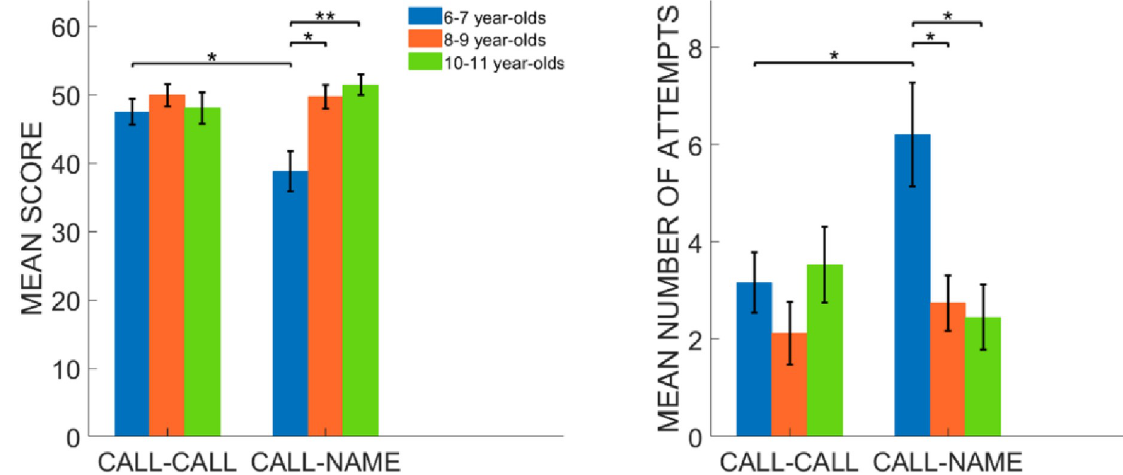
Fig 1. Performance analyses. Data are presented as mean across participants; error bars represent standard error. The left panel shows the results for the score parameter; the right panel represents the results for the number of attempts parameter. In the call-name condition, 6–7 year-olds reached a lower score and employed a greater number of attempts compared to the other two groups and the call-call condition. Asterisks indicate significant differences (see Results section for details). One asterisk ( � ) represents p < 0.5 Two asterisks ( �� ) represent p < 0.01 and three asterisks ( ��� ) p <